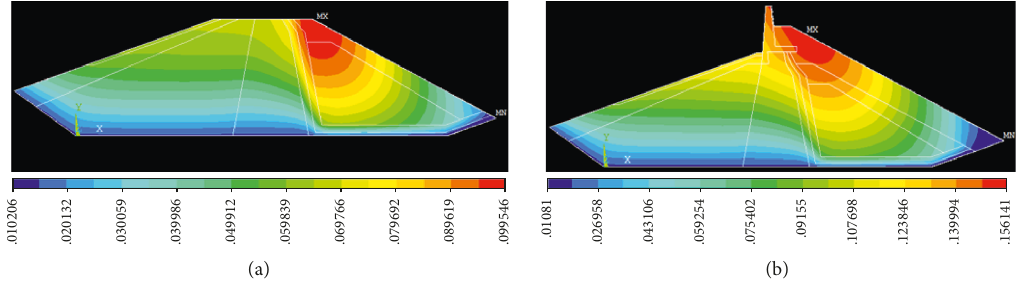
Figure 14: Contour of displacement of the dam foundation and earthfill embankment: (a) initial section and (b) final